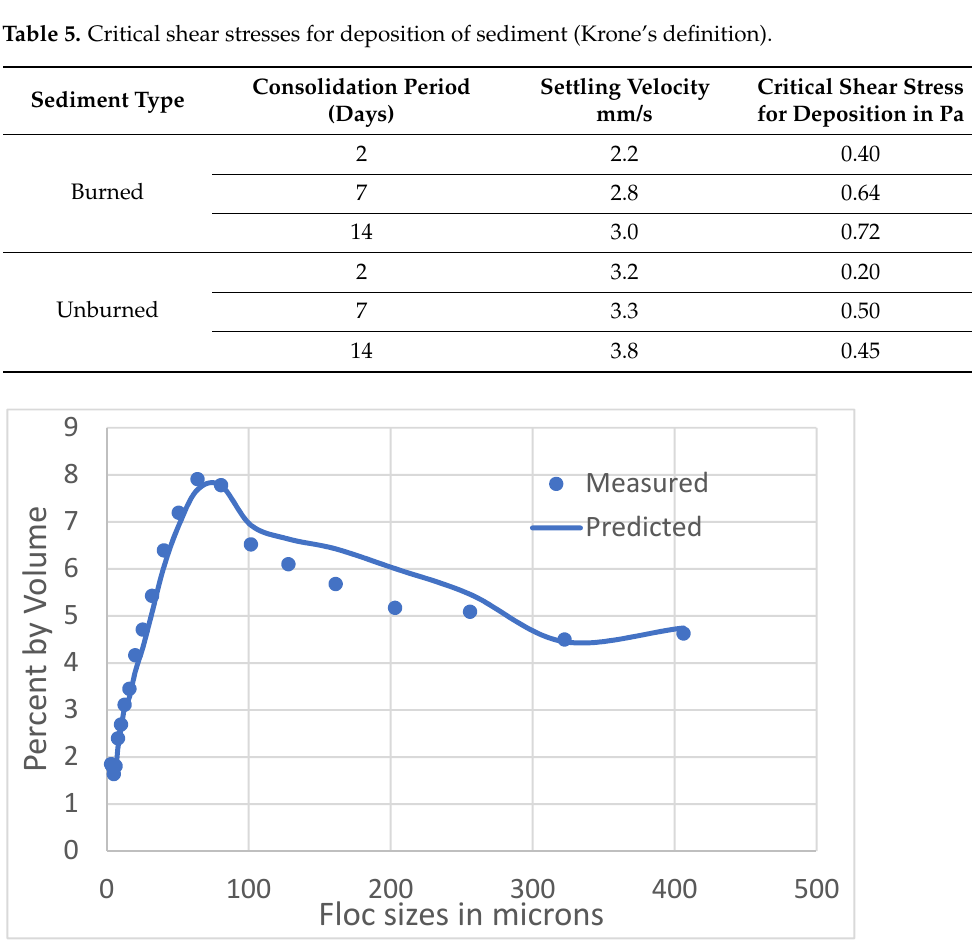
Figure 10. Comparison between measured size distribution and RIVFLOC prediction for the station downstream of the Lyons Creek confluence on the Crowsnest River.